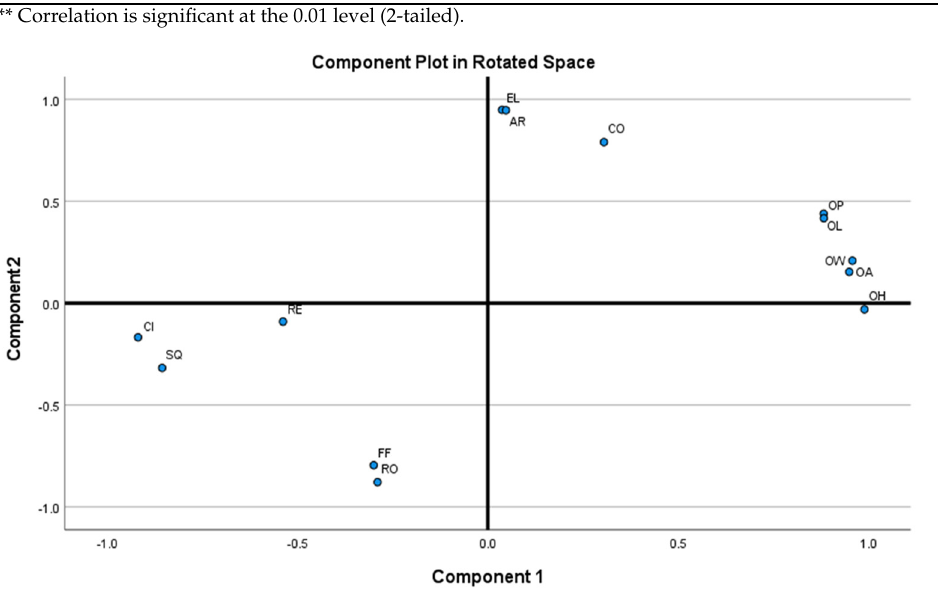
Figure 4. Component plot in rotated space of 13 otolith descriptors measured from otoliths of two D. kurroides stocks collected from Sulu and Sibuyan seas. Table 4. Summary of independent sample t-tests on otolith descriptors of D. kurroides from Sulu and Sibuyan